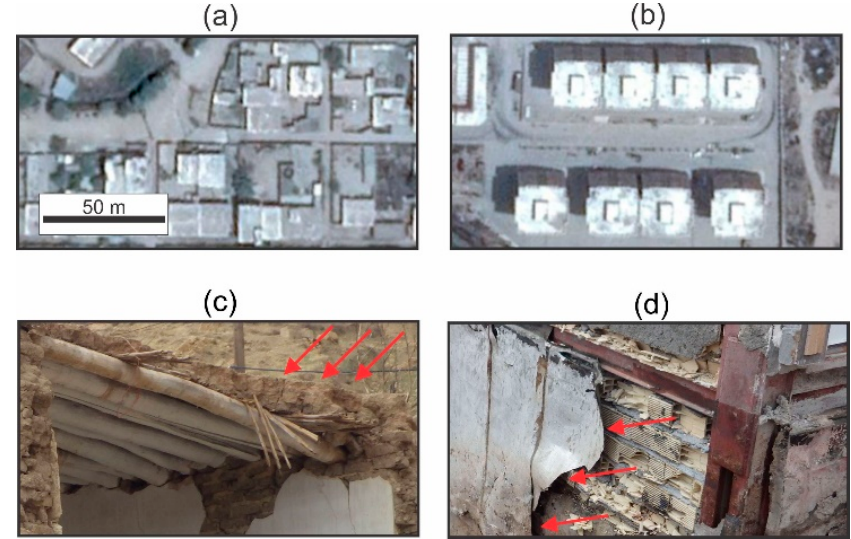
Figure 4. ( a , b ) Samples of rooftops of old and new buildings in Sarpole-Zahab obtained from DigitalGlobe’s WorldView satellites. Their locations are shown in Figure 2 (boxes A and B). ( a ) Old buildings in the center of the town mainly have darker roof colors, which are associated with cob materials; ( b ) New buildings in the western part of the town have brighter roof colors, which are associated with bituminous waterproofing materials with a thin silver color outer layer; ( c , d ) Samples of cob and bituminous materials used in old and new buildings, respectively.